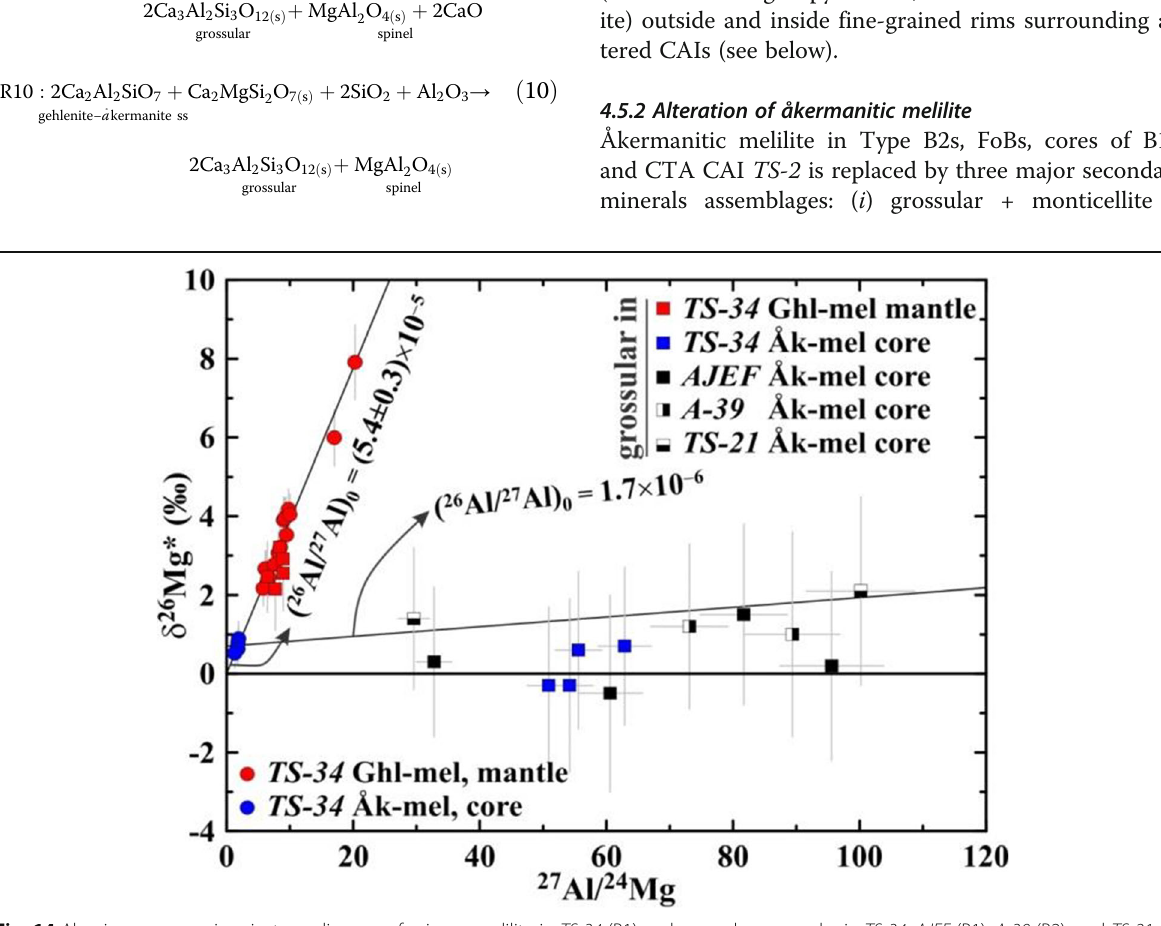
(salite-hedenbergite pyroxenes, andradite and wollaston-